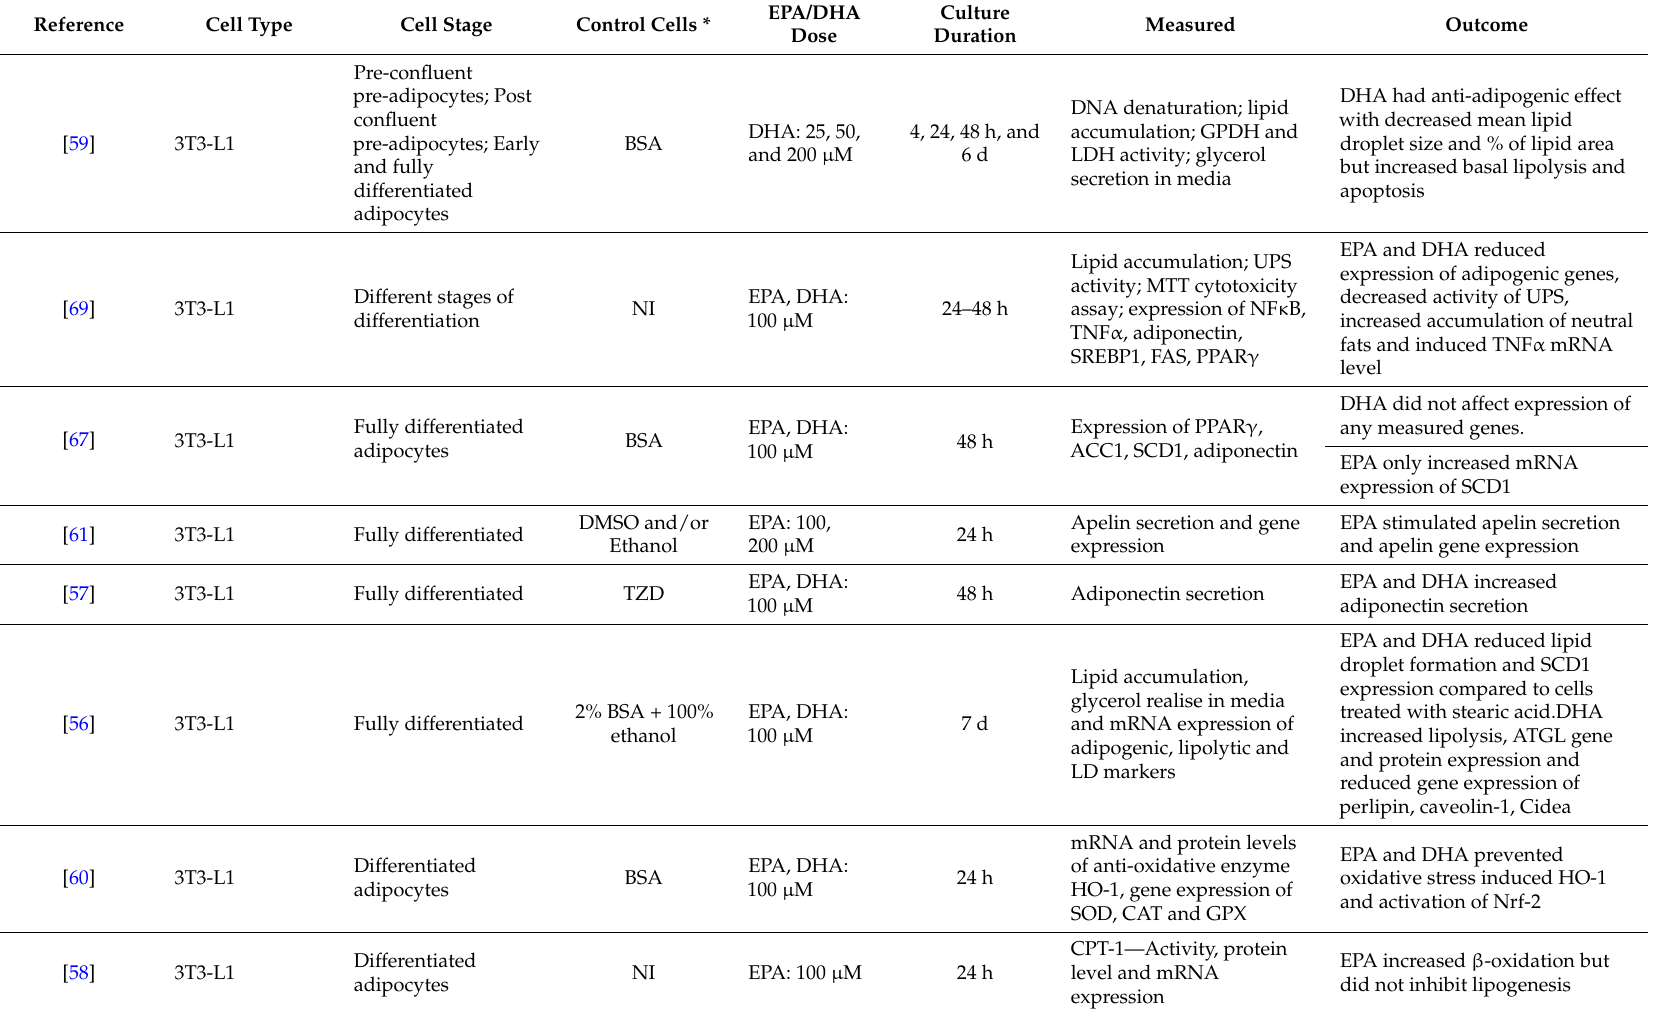
Table 4. Overview of cellular studies investigating the effect of EPA and DHA supplementation on markers of adipocytes metabolism and